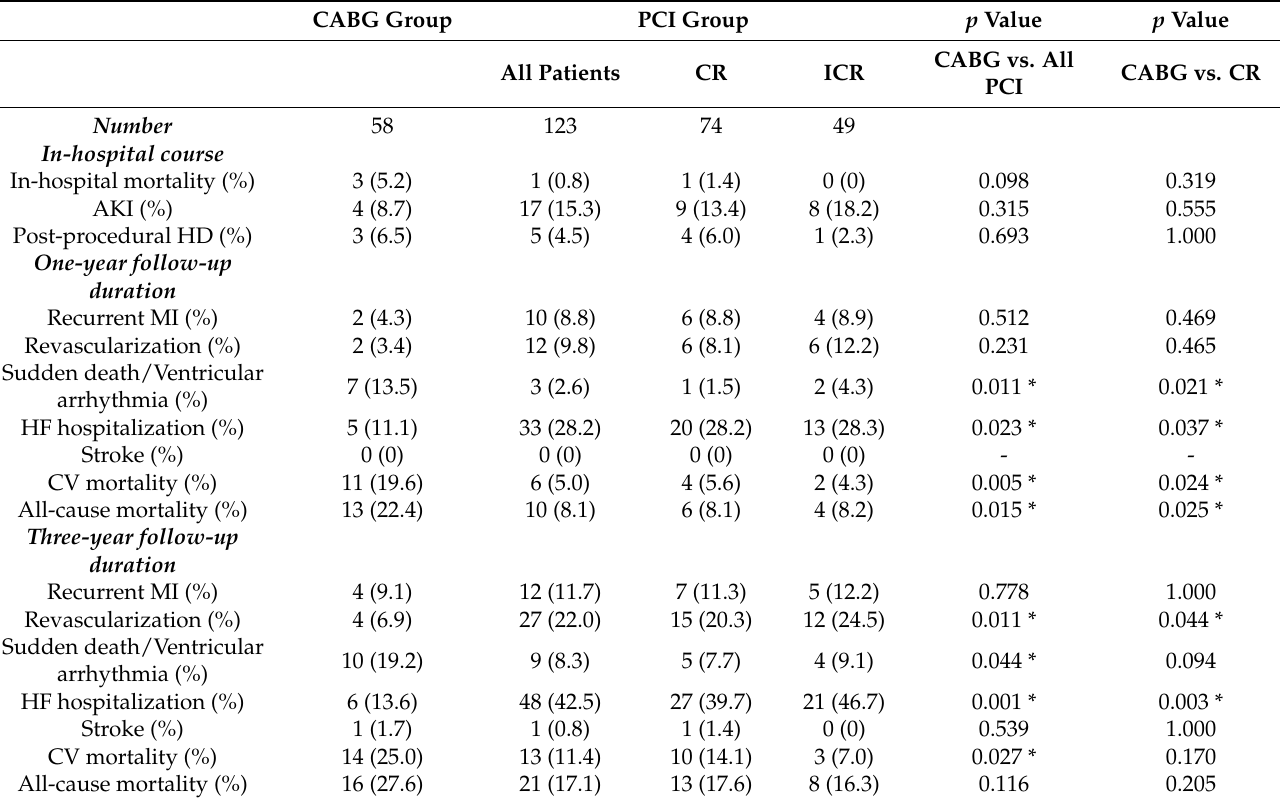
Table 2. Clinical outcomes of the study patients.